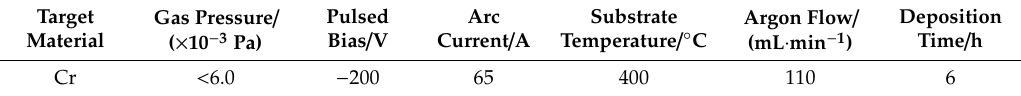
Table 1. Preparation process parameters of Cr coating deposited by multi-arc ion